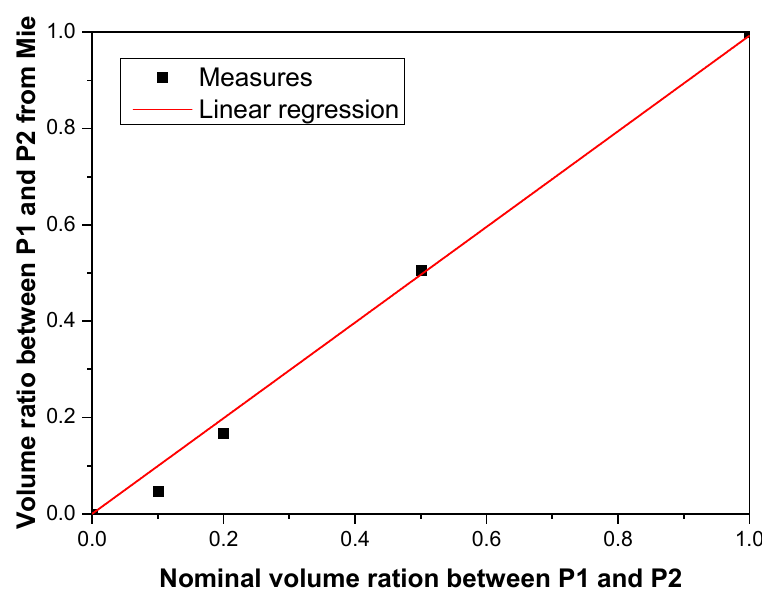
Figure 9. Comparison between the volume ratio of P1 and P2 suspensions determined from extinction spectroscopy and the nominal volume ratio. The linear regression is depicted as a red line. The slope of the linear regression is 0.99 ± 0.22.